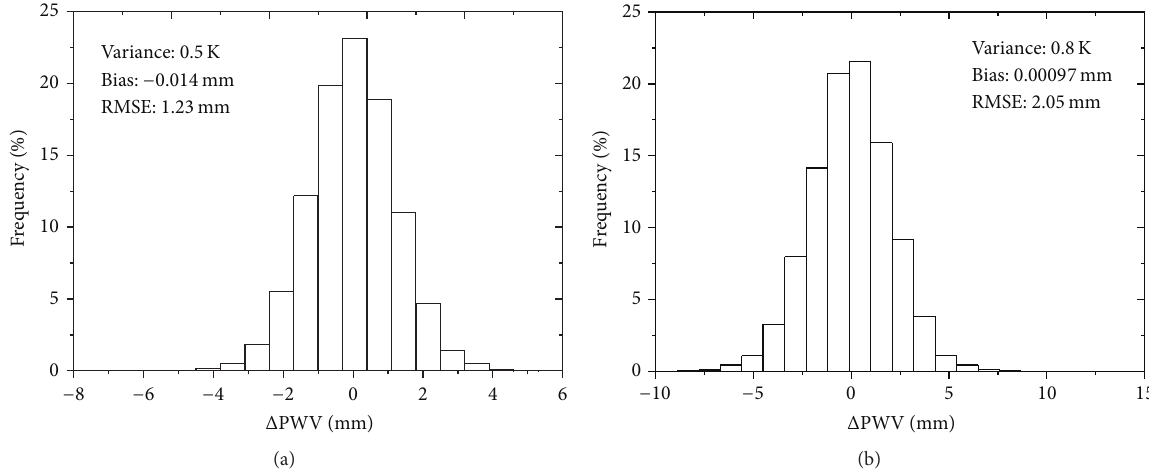
Figure5:HistogramsoferrorsbetweenthenewlyestimatedPWV(usingthenewbrightnesstemperatureswithaddederrors)andtheoriginal PWV when (a) the standard deviation of the 𝑇 𝐵,18.7 errors is 0.5 K and (b) the standard deviation of the 𝑇 𝐵,23.8 errors is 0.8 K.